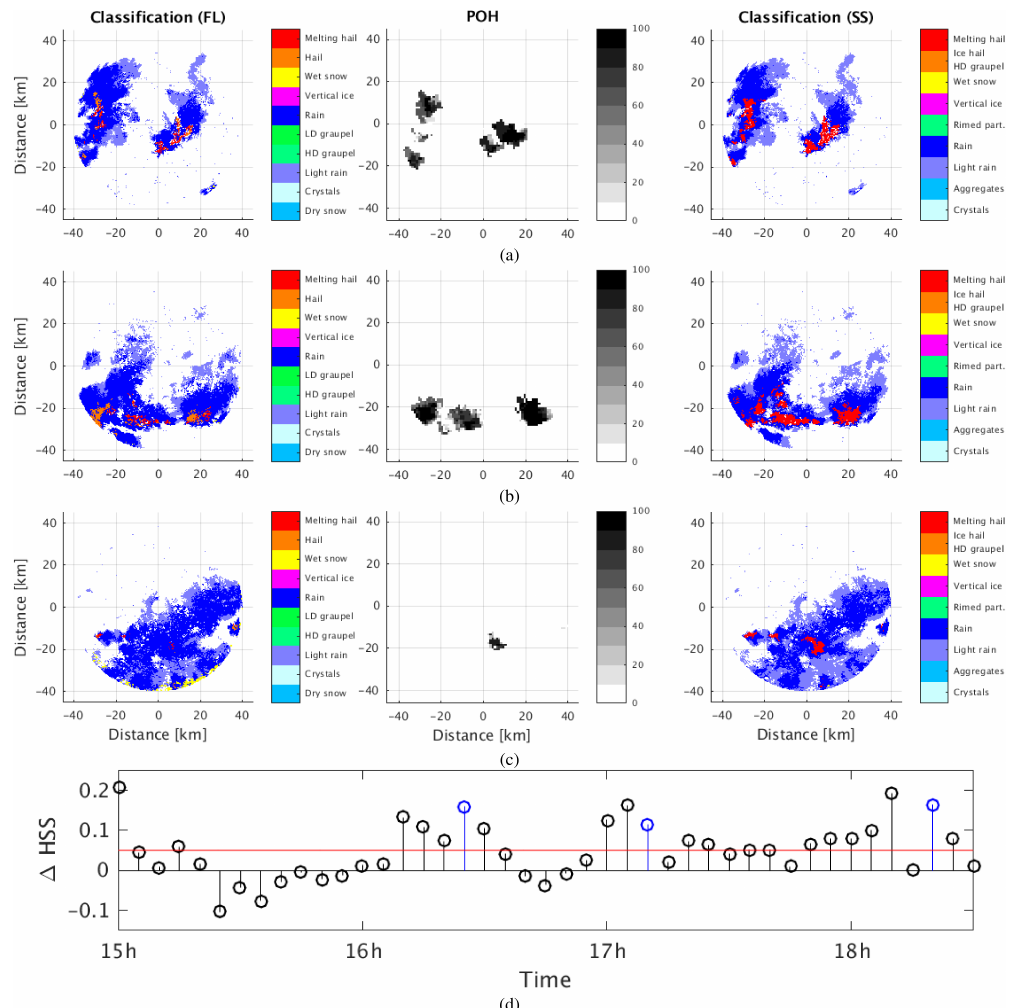
Figure 10. Comparison of fuzzy-logic-based method (FL) and our semi-supervised method (SS) with the probability of hail (Nisi et al., 2016) – Albis radar, 2 . 5 ◦ elevation, 12 June 2014: (a) 16:25, (b) 17:10, (c) 18:20; (d) along with the quantitative evaluation of matching ( (cid:49) HSS), averaged over three elevations (1, 1 . 6 and 2 . 5 ◦